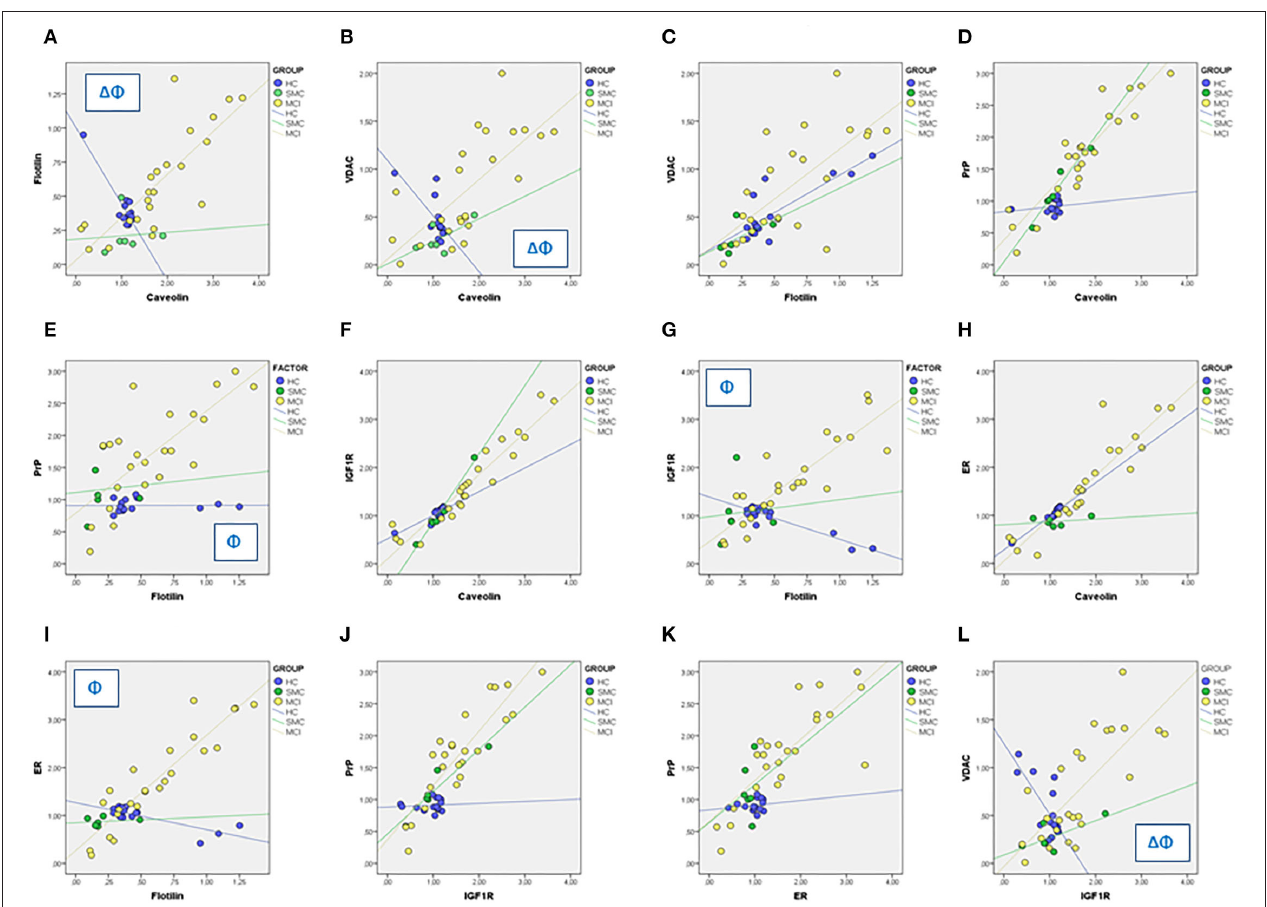
FIGURE 4 | Linear regression analyses for different associations between signalosome proteins in the CSF of HC, SMC, and MCI groups. The regression coefficients and statistical significances in panels (A–L) are indicated in Table 2 . 1 : p < 0.05 HC vs. SMC. 8 : p < 0.05 HC vs. MCI.